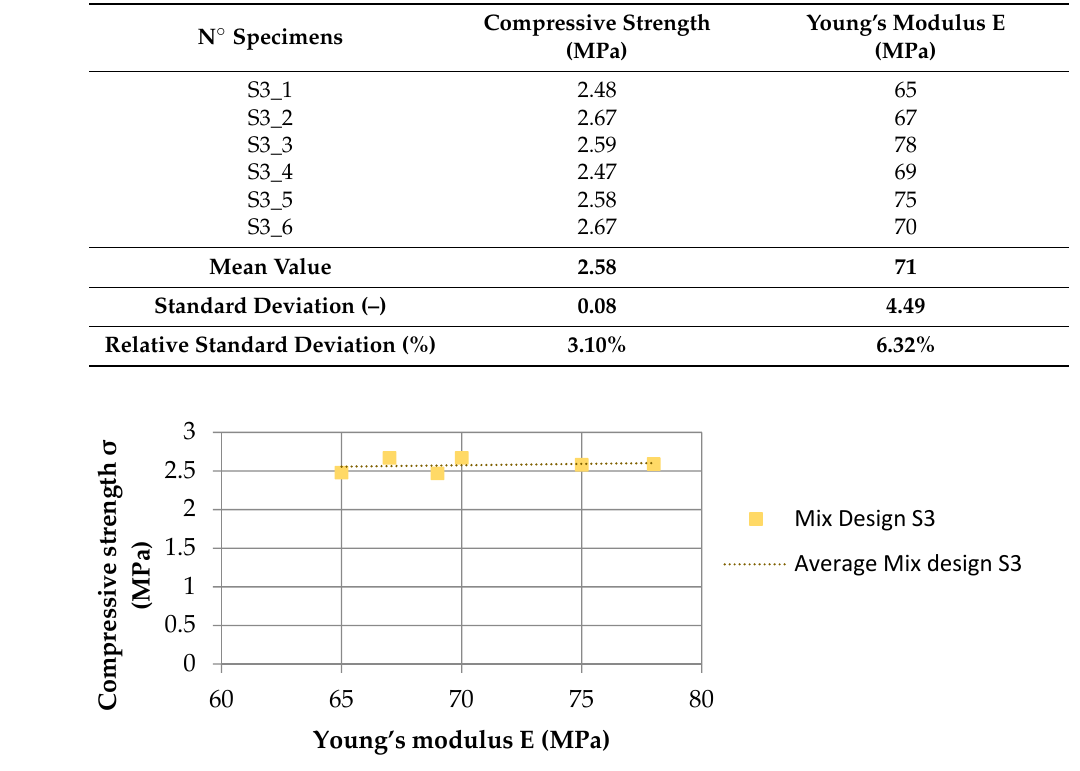
Figure 9. Compressive strength of S3_1–S3_6 specimens vs. the Young’s modulus.